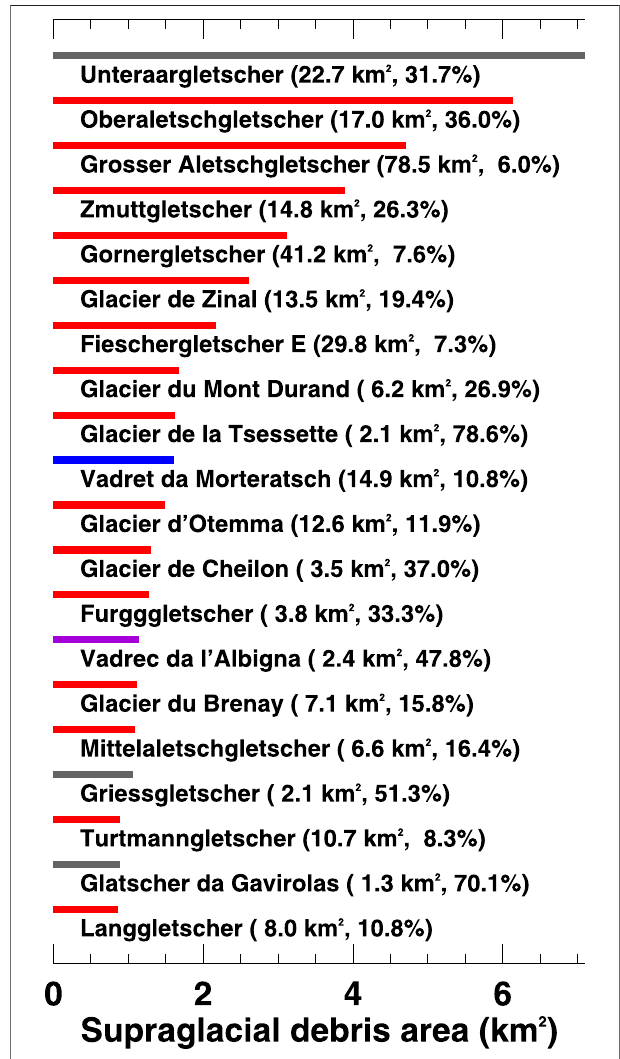
FIGURE 7 | SGI2016 glaciers ranked according to their absolute area with supraglacial debris. For each glacier, the total area and the share of debris-cover is stated. Colors refer to the main hydrological catchment (grey: Rhine, red: Rhone; purple: Po; blue: Danube).